Question: Generate an informative caption for the figure above.
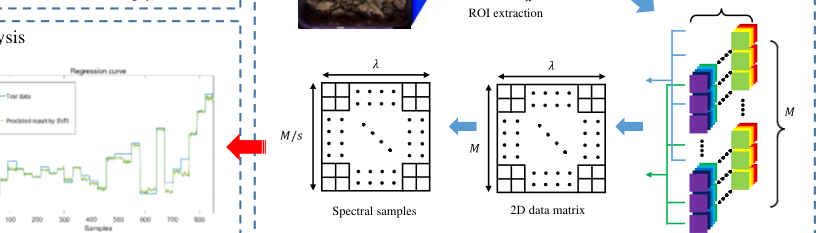
Answer: illustrates the proposed workflow of data processing.  Following data acquisition, the region of interest (ROI) in the  central area is extracted to eliminate regions near the boundaries  that contain shadows. Subsequently, an adaptive thresholding  technique [7] is applied to the ROI to further remove shadow  regions caused by an uneven surface that may obstruct the light  from being evenly distributed on the peat. Let M denote the  number of pixels in masked region of interest, and we randomly  selected s pixels and calculate their average value as a  representative spectral sample to compensate for the fact that the  distribution of phenols on the surface is very uneven. To this end,  we would have M/s spectral samples extracted from the  hypercube. For SWIR data, the average number of pixels for  each class of peat and condensate is 1.04*105 and 1.44*104  respectively. For VNIR data, the average number of pixels for  each class of peat and condensate is 4*105 and 9*104  resp